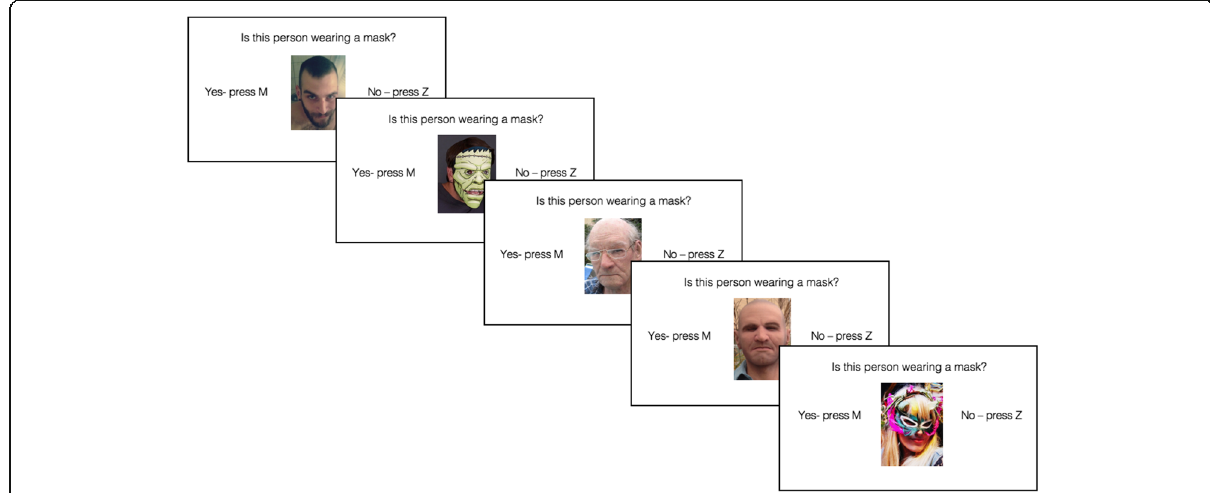
Fig. 2 Example of trial sequence in Study 1. Correct responses: Z, M, M, M, M. See main text for details